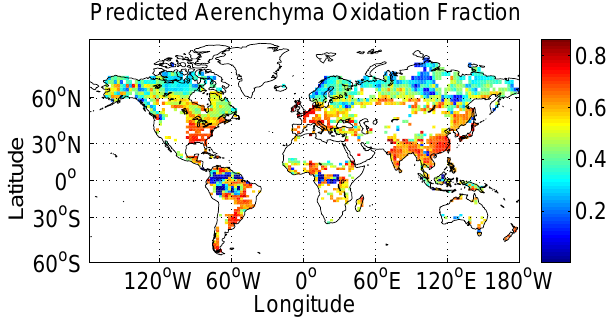
Fig. 8. Simulated fraction of annual CH 4 oxidized in rhizo- sphere; the global flux-weighted average is 0.6. For clarity, only gridcells with annual-average CH 4 emissions greater than 0.1mgCH 4 m − 2 d − 1 are